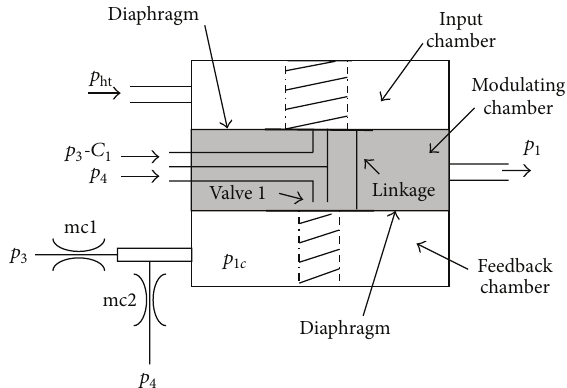
Figure 2: Functional structure of differential pressure